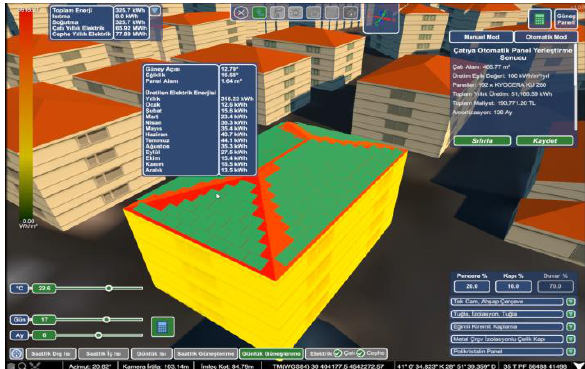
Figure 10. Solar estimation for the selected building rooftop.